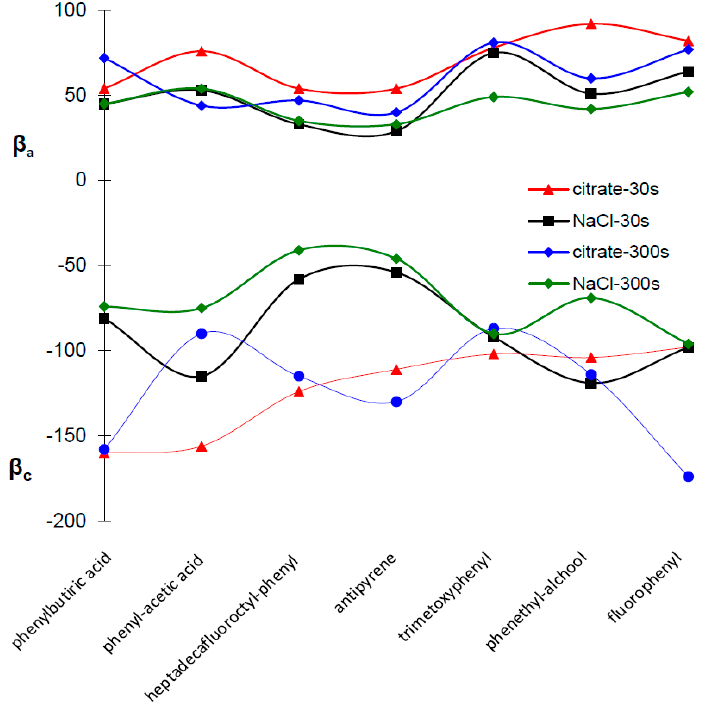
Figure 6. Cathodic Tafel slope ( β c ) and anodic Tafel slope ( β a ) for the copper surfaces covered with electrodeposited organic layers.